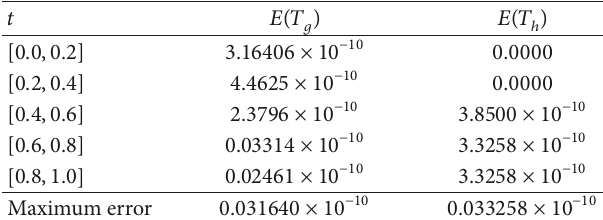
Table 3: The maximum error of interpolated initial condition functions to the analytical solution (see (16)). 𝐸(𝑇 𝑓 ) = max |𝑓(𝑥) − ̃𝑓(𝑥)| , for all 0 ≤ 𝑥 ≤ 1.